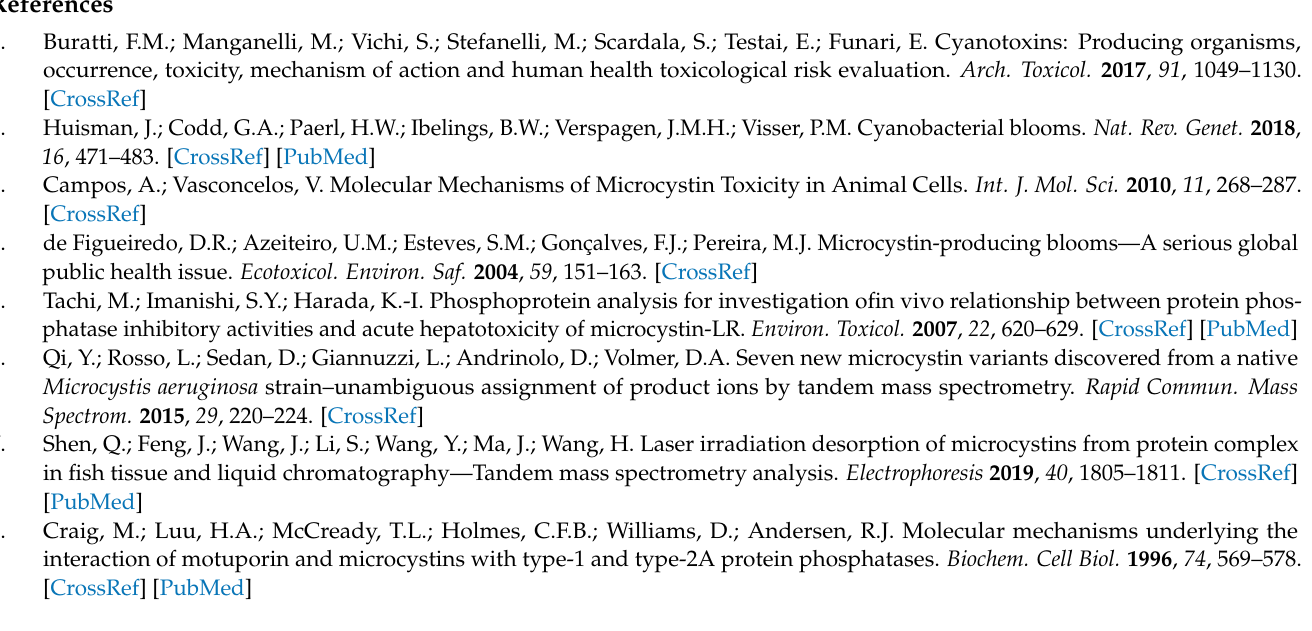
Table S2: Preparation and purification information for the electrophilic addition samples of MCLR. Table S3: The candidate interaction parameters between MCLR/MCLR-BTPs and